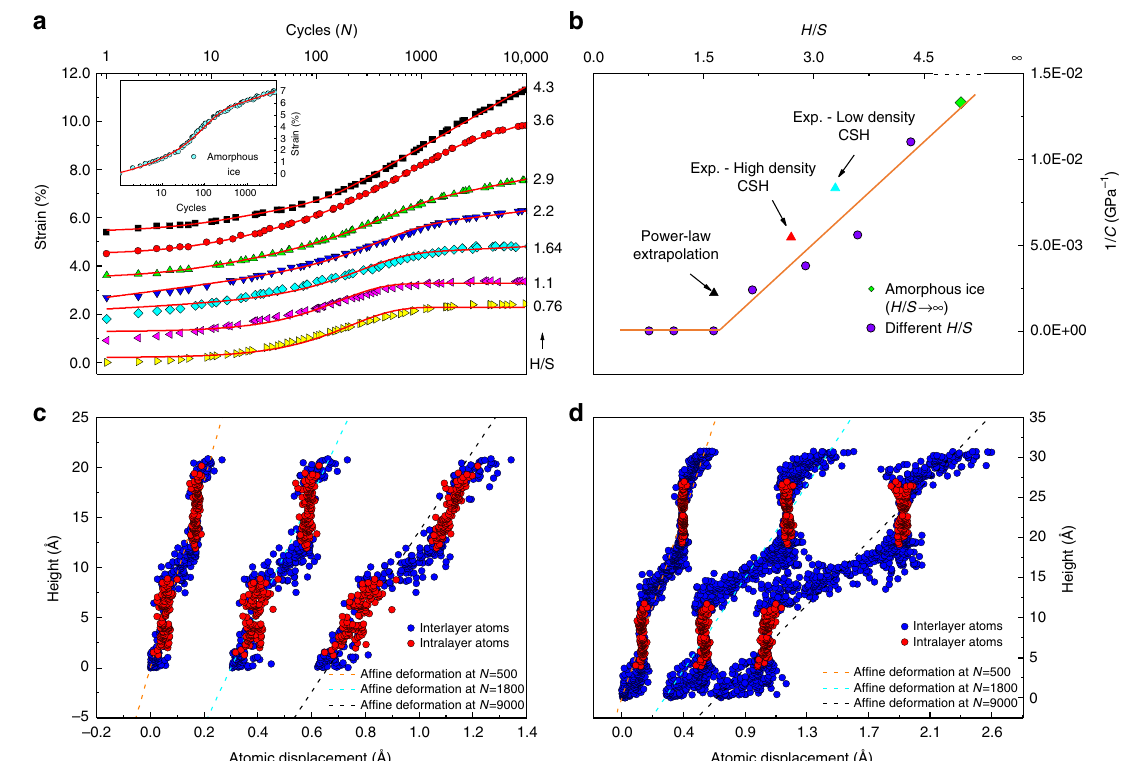
Fig. 5 The impact of nanocon fi ned water content on the time-dependent properties of C-S-H during reloading stage. a A logarithmic component gradually appears as the water content increases. The inset shows the same experiment carried out on a box of amorphous ice. The graphs have been shifted for clarity. b Variation of creep compliance with the nanocon fi ned water content and their direct comparison with experimental values 52 for the high and low density C-S-H using nanoindentation technique. A transition is observed in the region, where intraglobular water appears. We can also see how the values converge to the case of a box of amorphous ice in the limit. c , d Horizontal deformation of the sample with height for a sample with low water content in ( c ) and high water content in ( d ). While at high H / S ratio the layers freely slide over each other without distorting the solid constituents, the sliding forces at lower H / S content interlocks adjacent layers that promotes the shear deformation of the solid parts. This implies that the design of non-aging C-S-H materials is closely tied to molecular manipulation of interglobular interlocking structural 28.8 ± 1.3 GPa for the average of the resultant shear modulus.